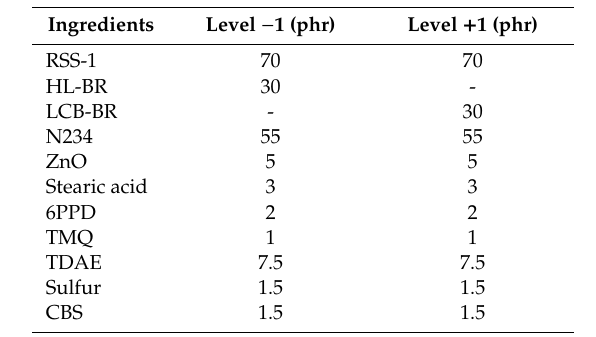
Table 2. Rubber compound formulations.